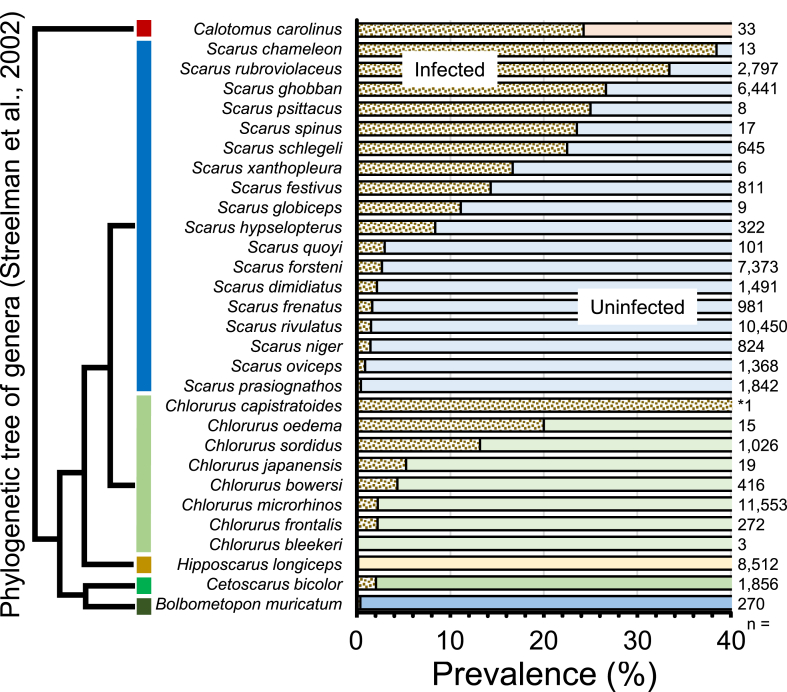
Phylogenetic tree of genera in Scarini of Labridae (modified from Streelman et al., 2002) and parasite prevalence in each species. *: 100%.